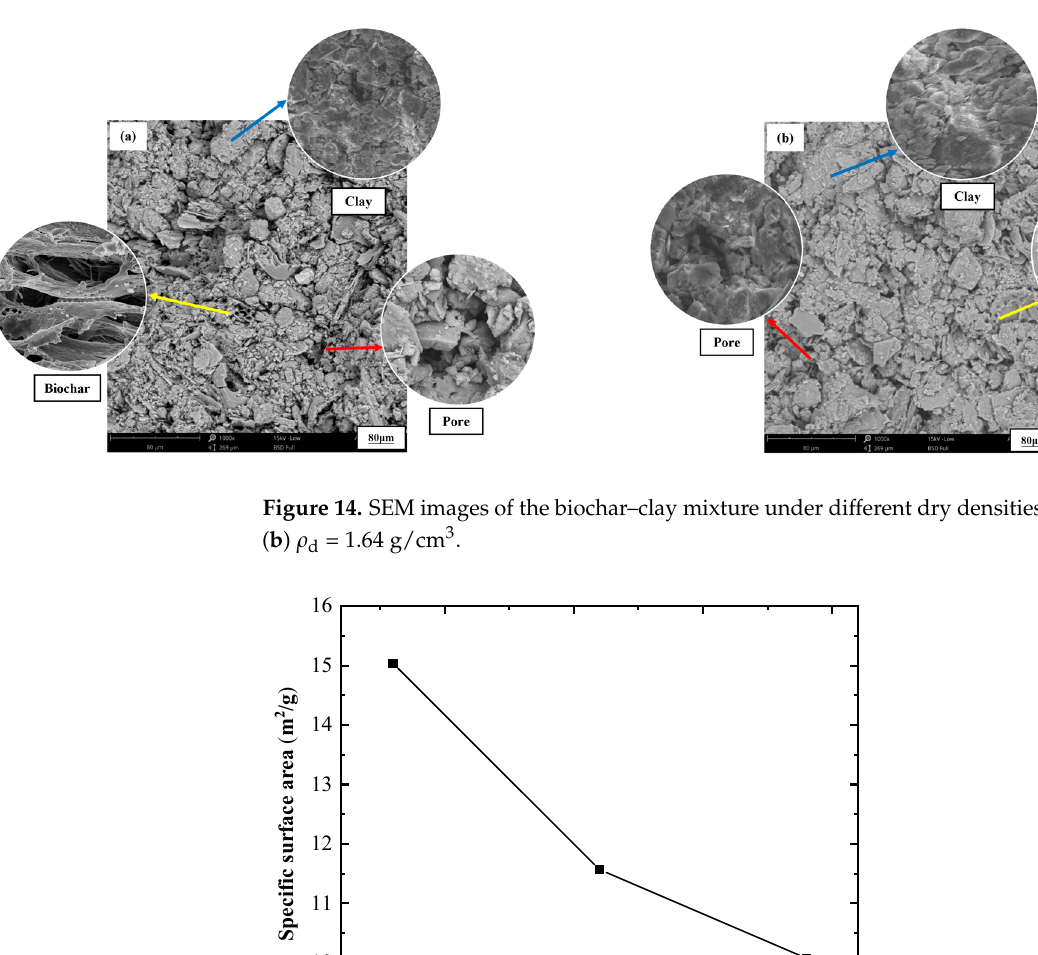
Figure 15. The specific surface area of the biochar–clay mixture under different dry densities.